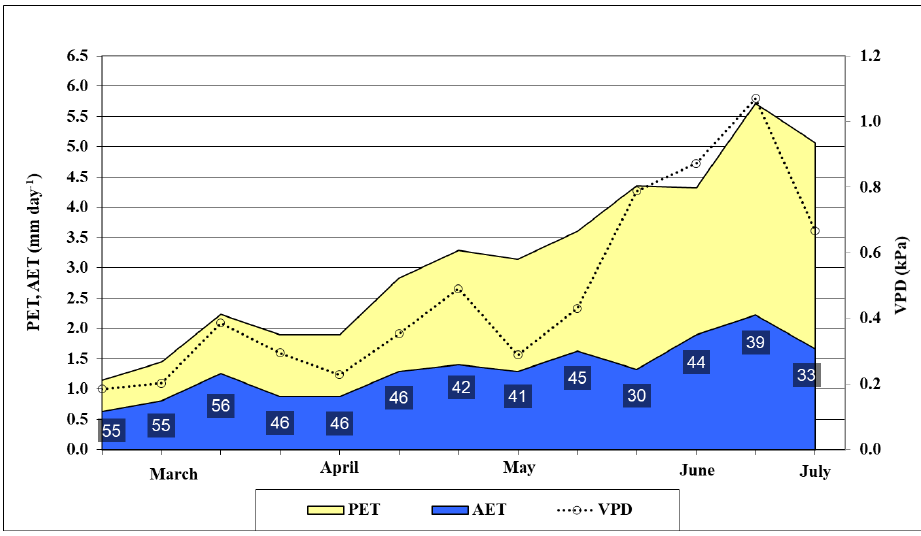
Figure 2. Potential (PET) and actual (AET) evapotranspiration, AET/PET ratio (%), and VPD in oats from March to June (Debrecen, 2021). Average of the decades. VPD: Water pressure deficit, calculated using meteorological data.